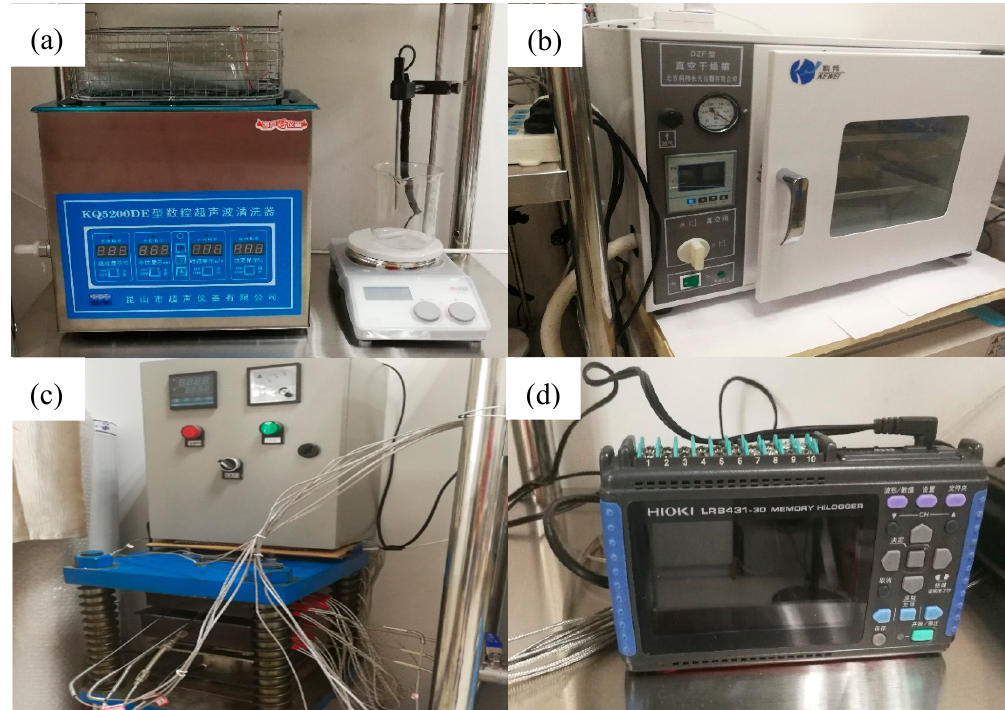
Figure 7. Main instrument and equipment of the vacuum infiltration hot-press forming experimental system: ( a ) ultrasonic cleaning and magnetic stirrer; ( b ) vacuum heating infiltration box; ( c ) hot-press forming and temperature control device; ( d ) data acquisition instrument.